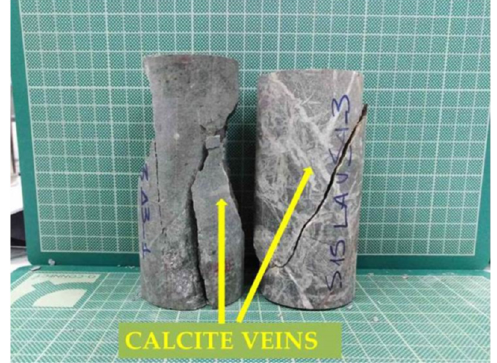
Figure 1. Prasinites with sparse ( left ) and dense ( right ) network of veins filled with calcite.